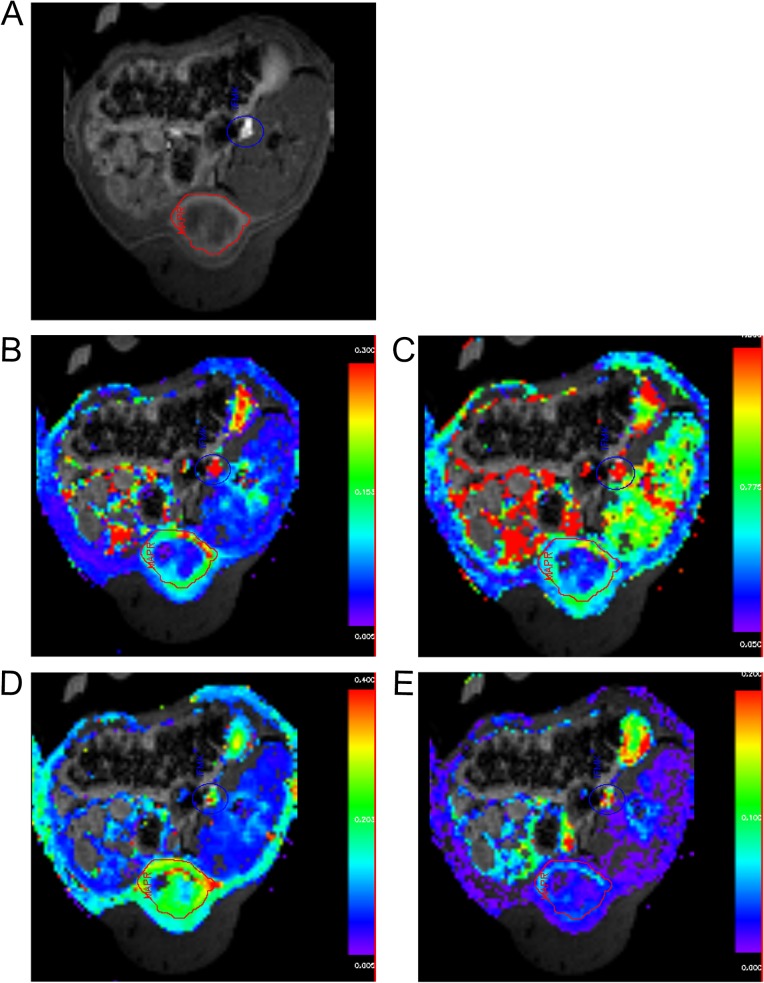
Illustrative parametric maps using 3-parameter physiological model, individual VIF and pixel based analysis.Same animal as Fig 1. A) Source trans-axial DCE-MRI image [blue outline is VIF input mask; red outline is tumor ROI mask]; B) K
trans, C) k
ep, D) v
e, and E) v
p parameteric maps.